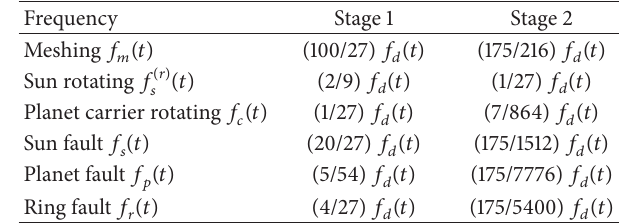
Table 3: Planetary gearbox characteristic